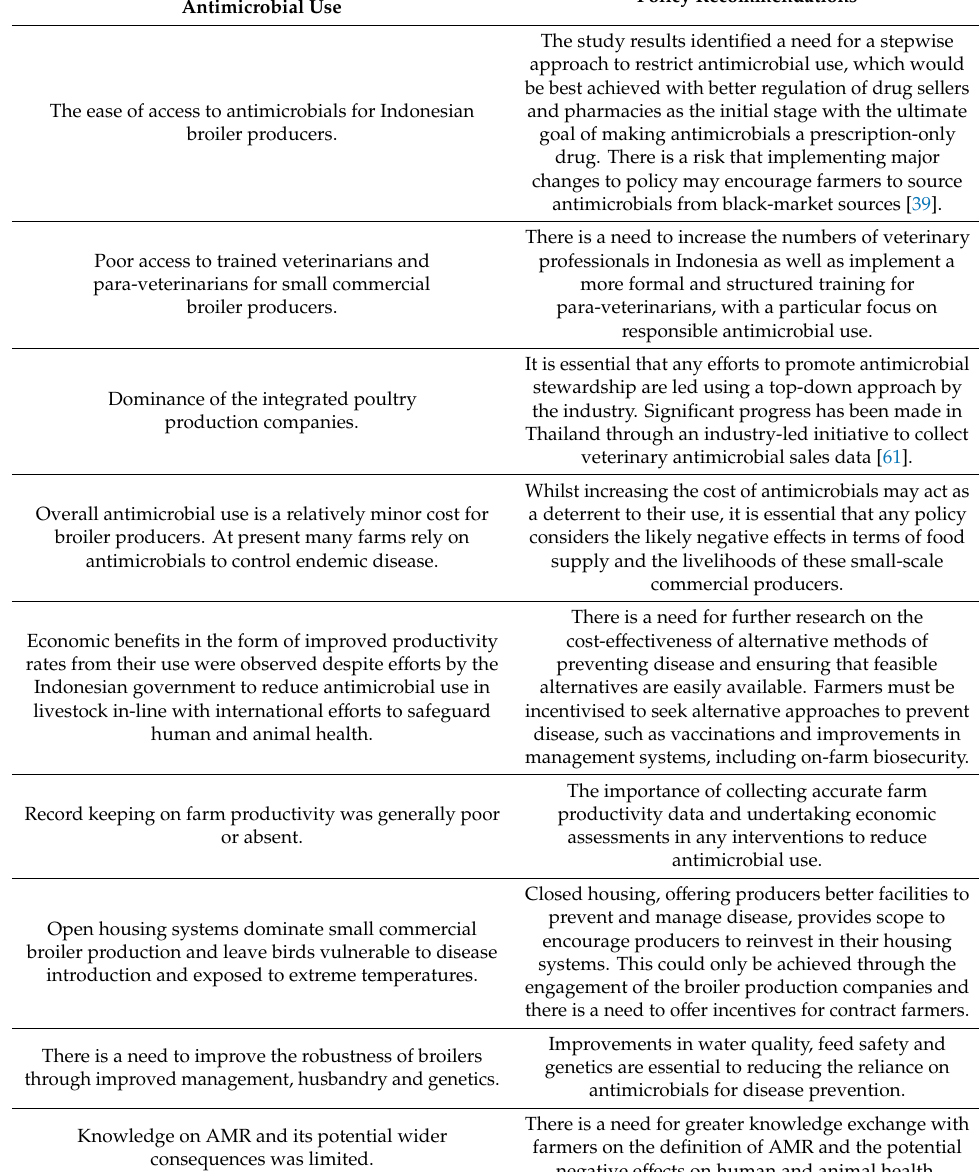
Table5. Keyfindingsandpolicyrecommendationsfromastudyexploringtheeconomicandbehavioural drivers of antimicrobial use in broilers in Indonesia.